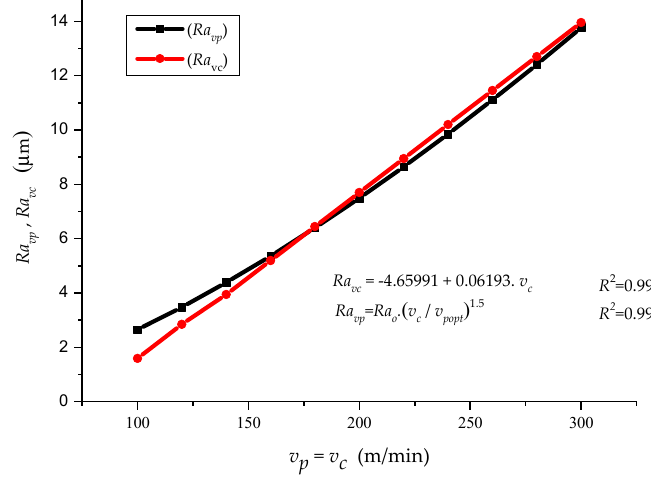
Figure 11. Comparison of ( Ra vp , Ra vc ) = f ( v c ).